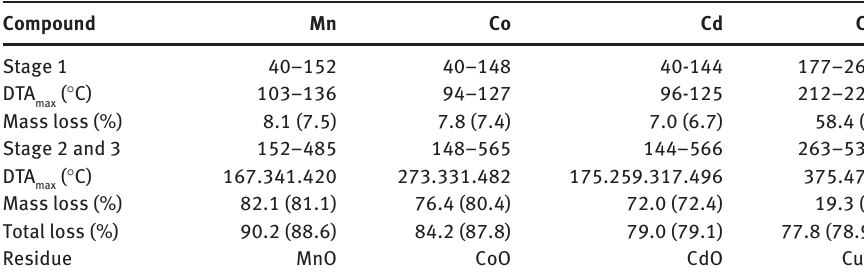
Calculated values are given in